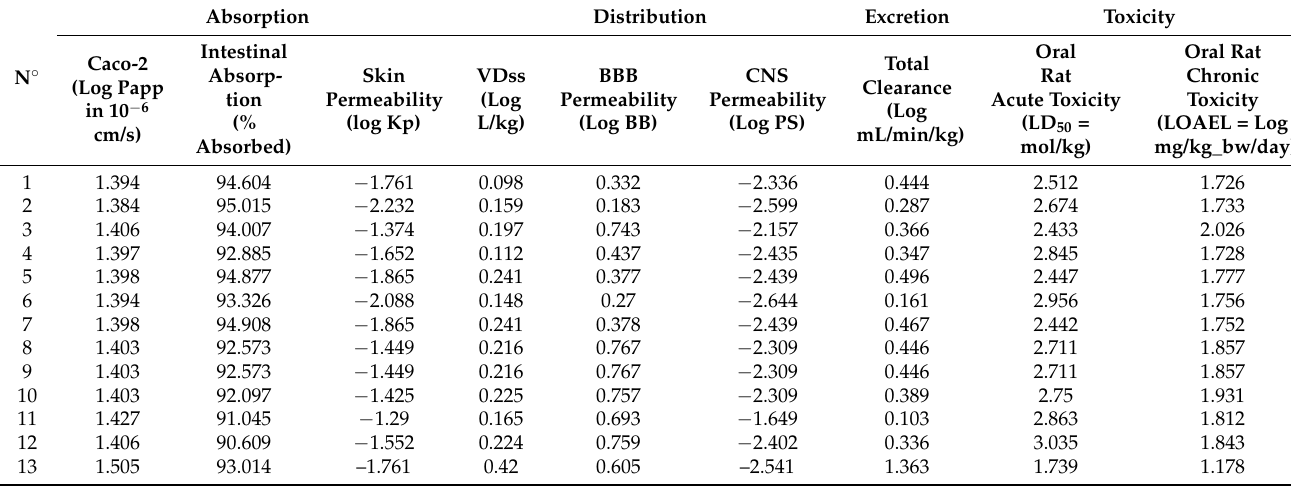
Table 4. ADMET properties of the chemical constituents of the A. sativum essential oil (in the metabolism analysis for CYP 2D6 inhibitors, CYP 3A4 inhibitors, renal OCT2 substrate, and hepatotoxicity, no data were